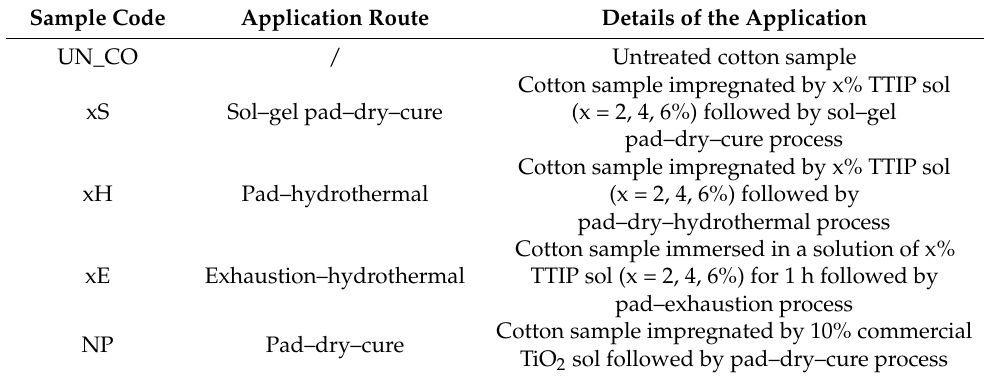
Table 3. Sample details and synthesis